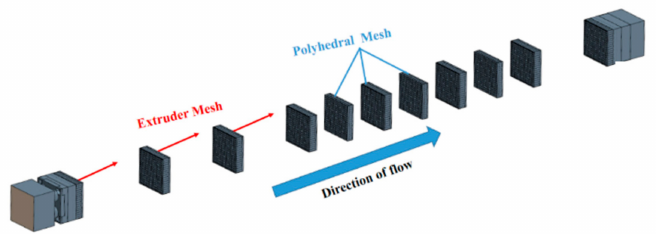
Figure 10. Mesh generation of the full-scale model.